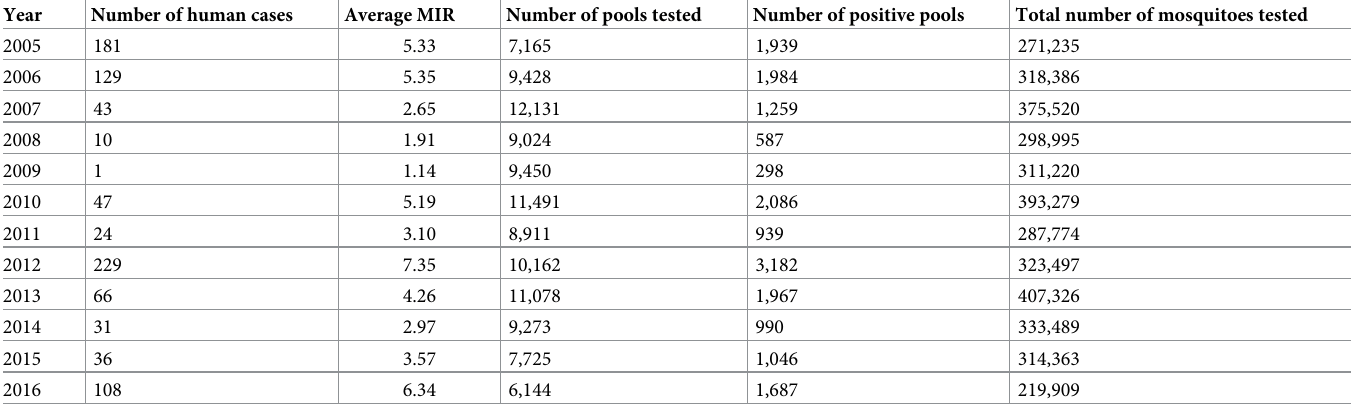
Table 2. Annual human WNV cases, average seasonal mosquito infection rate (MIR), and mosquito testing from 2005 to 2016 in Cook and DuPage counties.